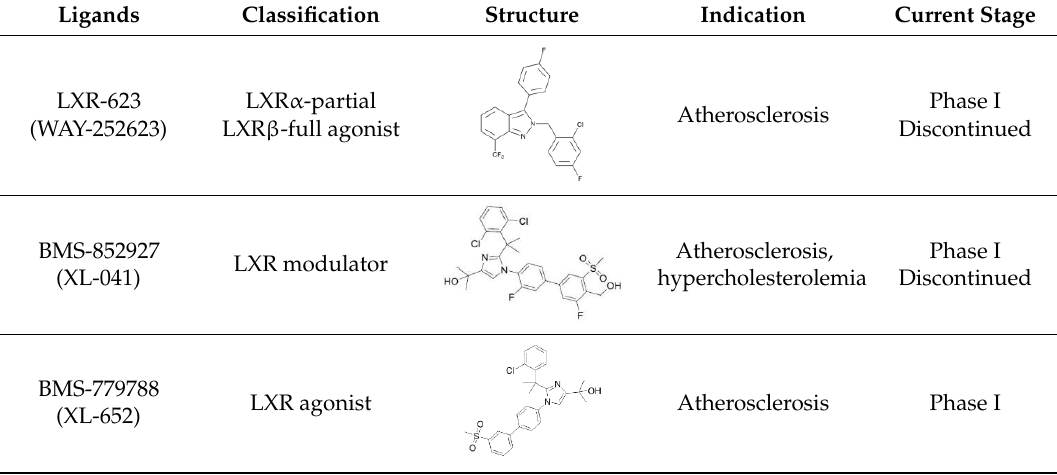
Table 2. Different LXR ligands and their development status regarding anti-atherosclerosis.